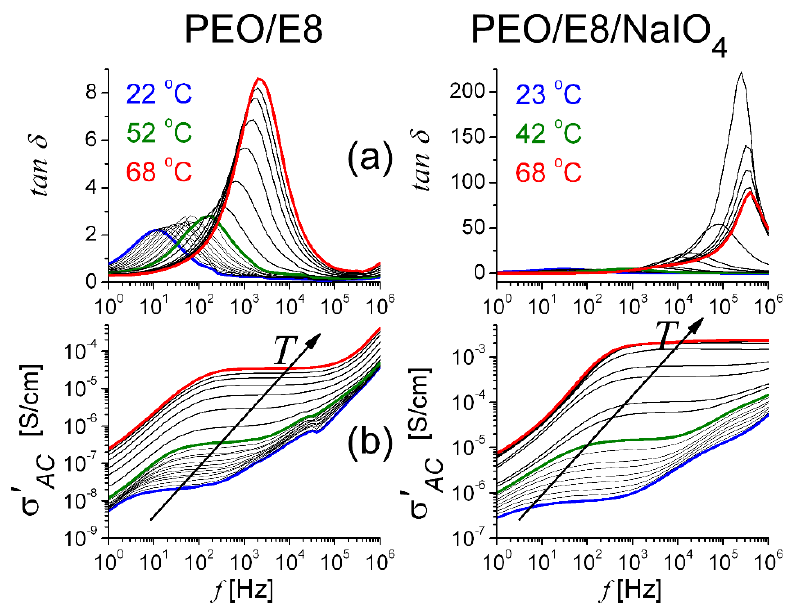
Figure 11. The variation of frequency-dependent dielectric loss tangent tan δ ( a ) and the real part of AC conductivity σ (cid:48) ( b ) at various temperatures for the studied polymer/LC composites PEO/E8 ( left ) and PEO/E8/NaIO 4 ( right ). The arrows show the effect of increasing temperature. Over the whole range measured from 1 Hz to 1 MHz, the temperature-dependent variations of the ′ 𝜎𝜎 𝐴𝐴𝐴𝐴